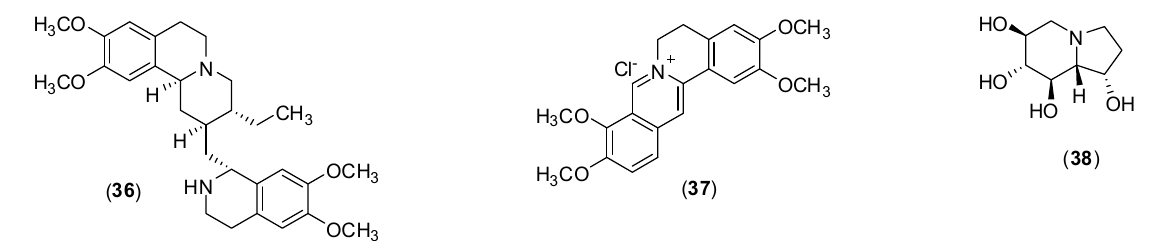
Figure 15. Structures of alkaloids 36 – 38